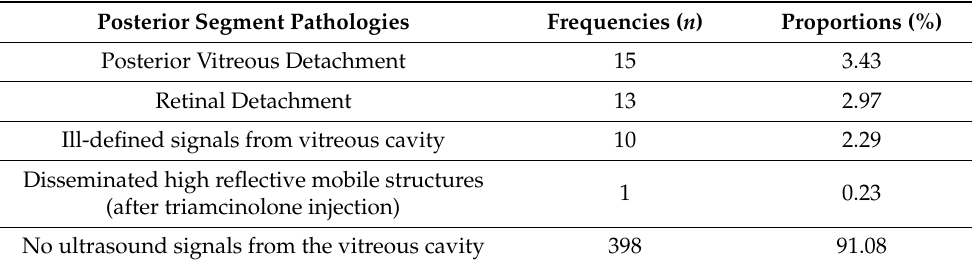
Table 1. B-scan ultrasonography findings.